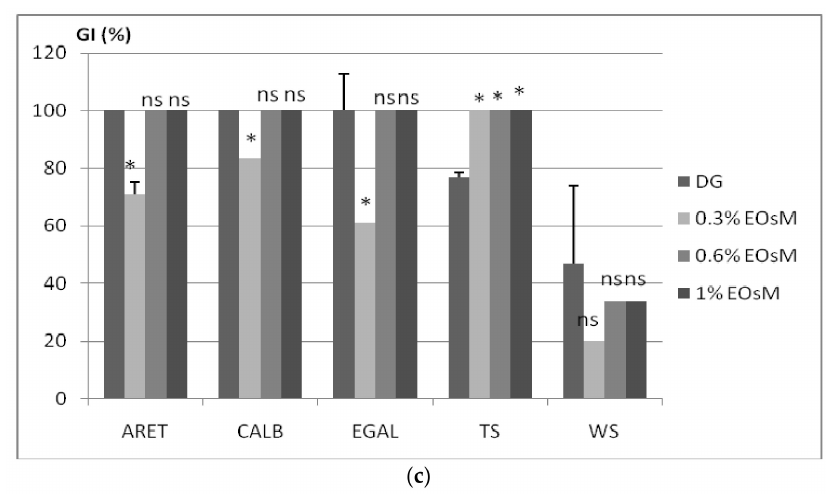
Figure 2. The effect of ( a ) Salvia officinalis essential oil—SEO; ( b ) Thymus vulgaris essential oil—TEO; and ( c ) their mixtures (EOsM) on seeds germination rate (GI) of Amaranthus retroflexus (ARET), Chenopodium album (CALB), Echinochloa crus-galli (EGAL), tomato (TS), and wheat (WS). * the value is significant different versus the control with Dual Gold (DG) at p < 0.05; ns—the value is no significant versus